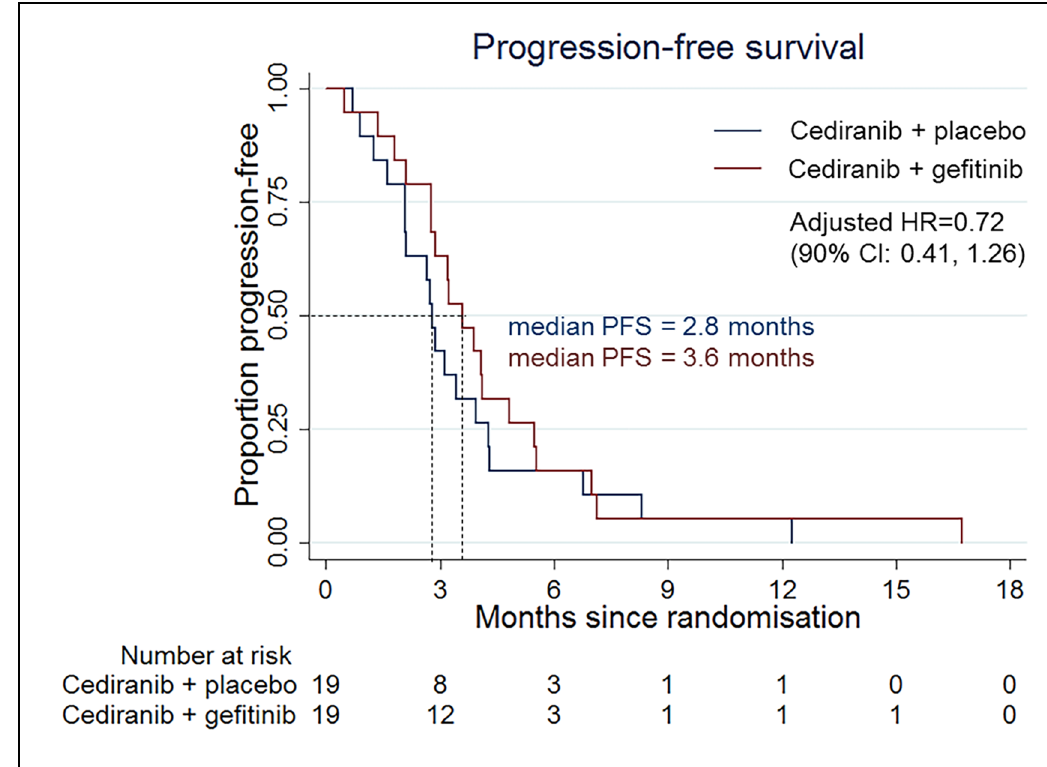
Fig 2. Kaplan-Meier plot for PFS in the ITT population.